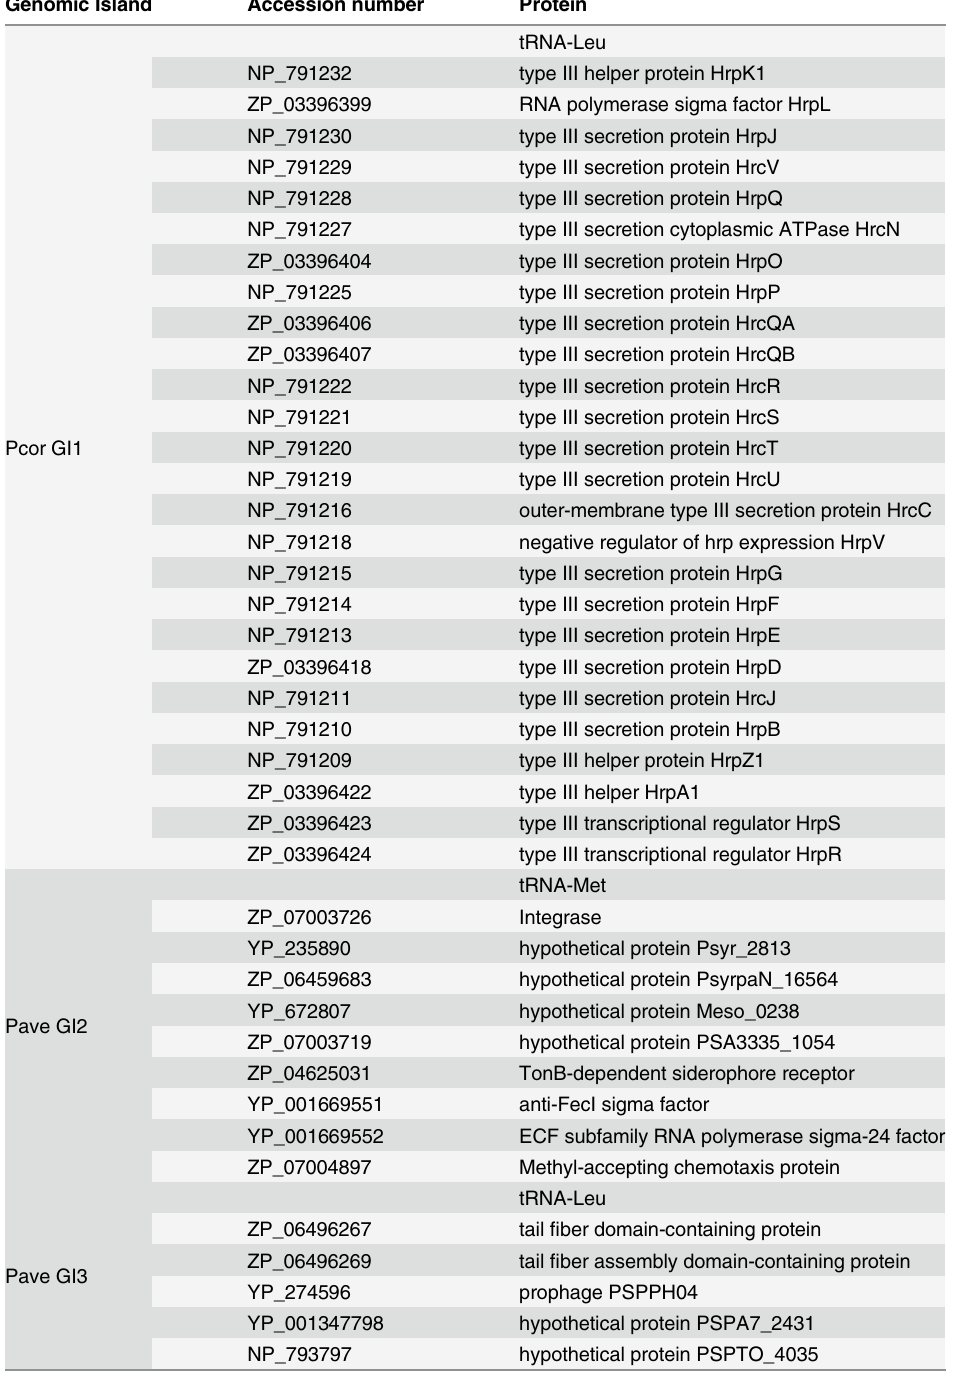
Table 5. Gene content in the region of the three genomic islands found in Pseudomonas avellanae and P . syringae pathovars avellanae , coryli and syringae strains all infecting Corylus avellana